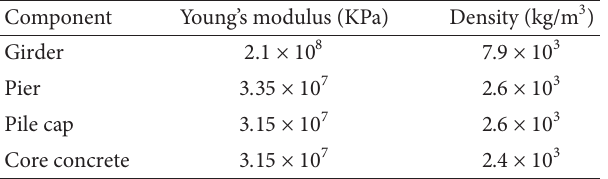
Table 4: Parameters of material models for bridge structures.